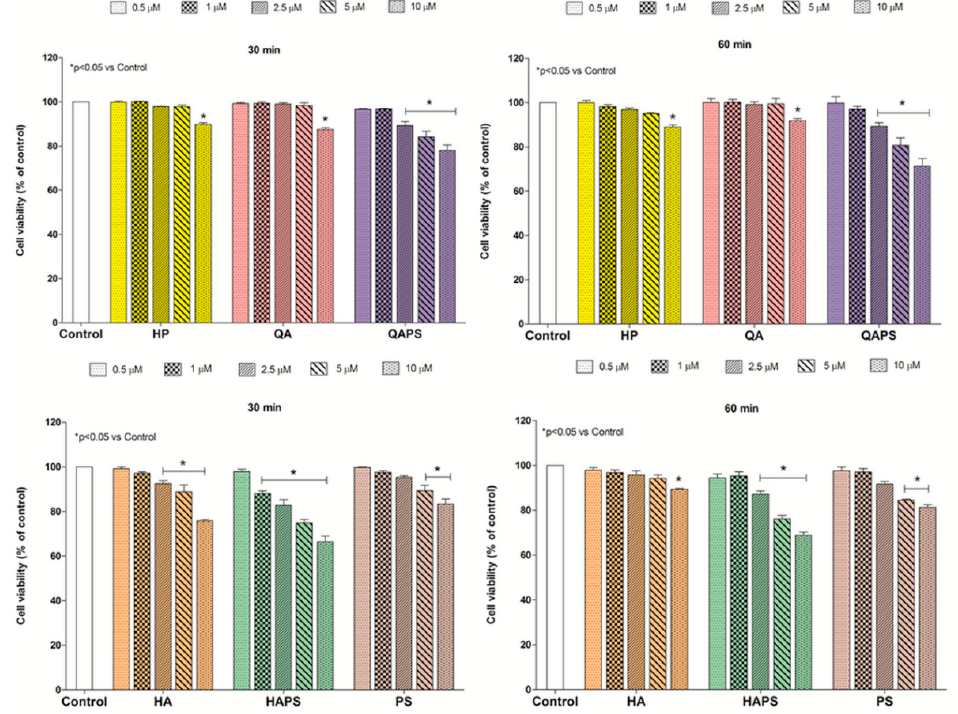
Figure 2. Effect of different concentrations (0.5–1–2.5–5–10 µM) of HP, QA, QAPS, HA, HAPS and PS on CACO-2 cell viability at increasing times of exposure (30 and 60 min). Data are reported as mean ± SD ( n = 3). * p < 0.05 vs. Control (ANOVA test).